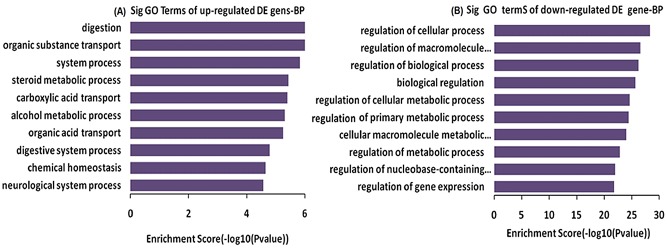
Gene ontology (GO) analysis used for analysis of the altered genes.A, The bar plot showed the top ten up-regulated Enrichment Score values of the significant enrichment; B, The bar plot showed the top ten down-regulated Enrichment Score values of the significant enrichment BP.